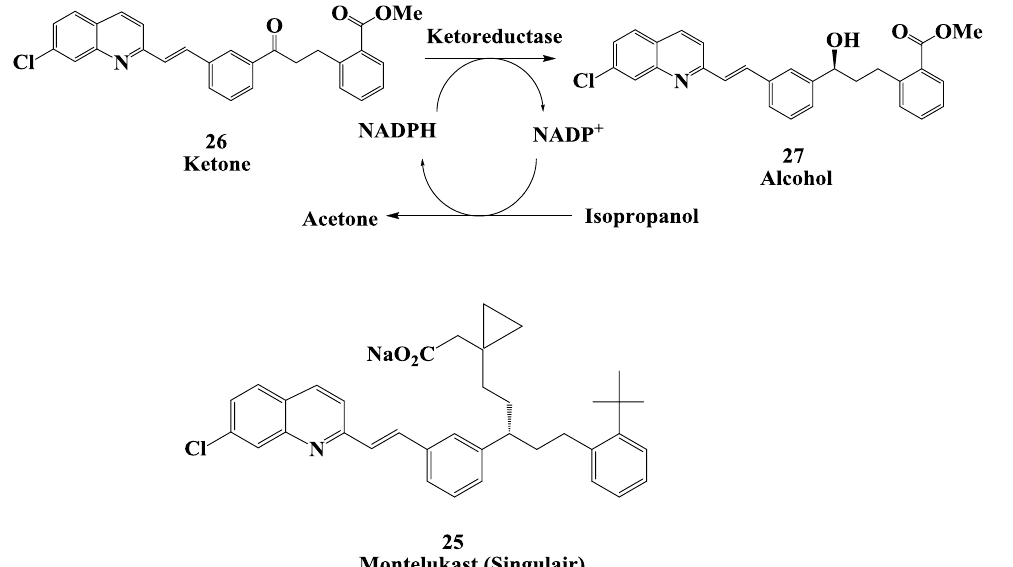
Figure 7. Enzymatic reduction process for synthesis ( S )-alcohol 27 for Montelukast